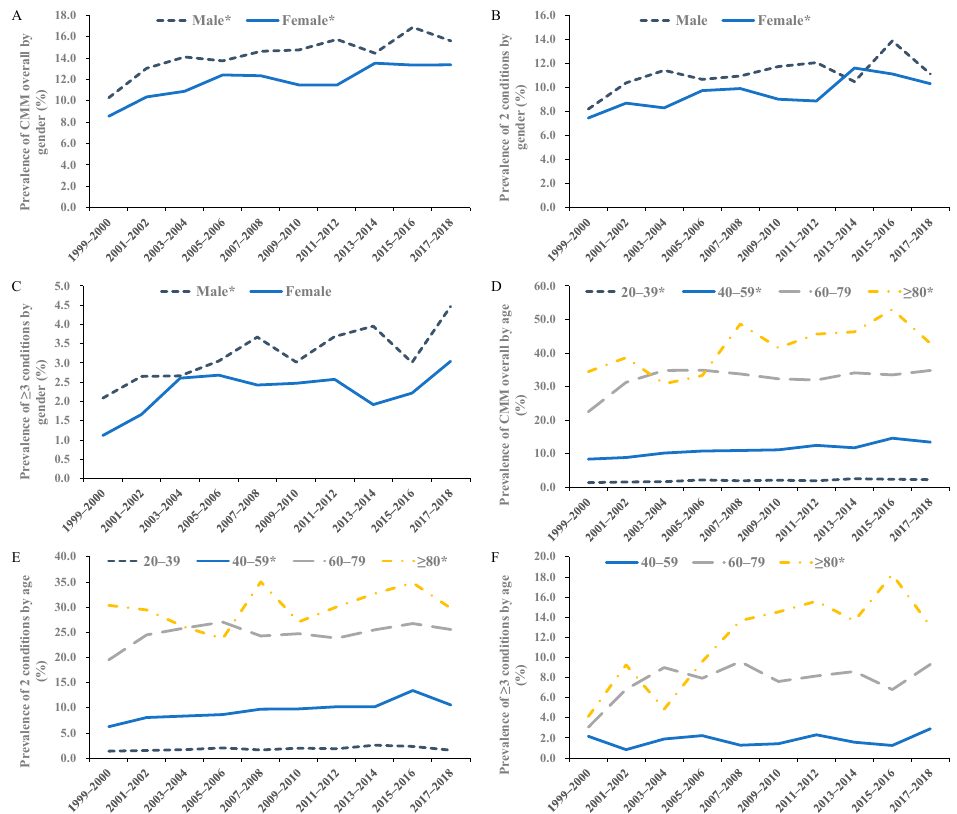
Figure 2. Trends in the age-adjusted prevalence of cardiometabolic multimorbidity by gender and age among U.S. adults, 1999–2018. Notes: The averaged trends were estimated with AAPC derived from joinpoint regression models. Panel ( A ): For CMM overall by gender; Panel ( B ): For concurrent two cardiometabolic diseases by gender; Panel ( C ): For ≥ three concurrent cardiometabolic diseases by gender; Panel ( D ): For CMM overall by age; Panel ( E ): For two concurrent cardiometabolic diseases by age; Panel ( F ): For ≥ three concurrent cardiometabolic diseases by age. The prevalence of 20–39 years subgroup for ≥ three conditions during 1999–2018 was too low to be estimated, which hindered the estimation of AAPC with joinpoint regression models, so the related trend is not shown in the figure. CMM, cardiometabolic multimorbidity; AAPC, averaged two-year cycle percentage change. * p for trend <0.05.